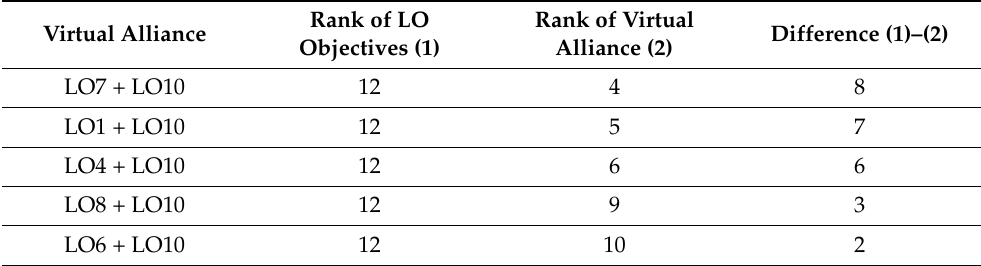
Table 11. The good alliances (calculated by